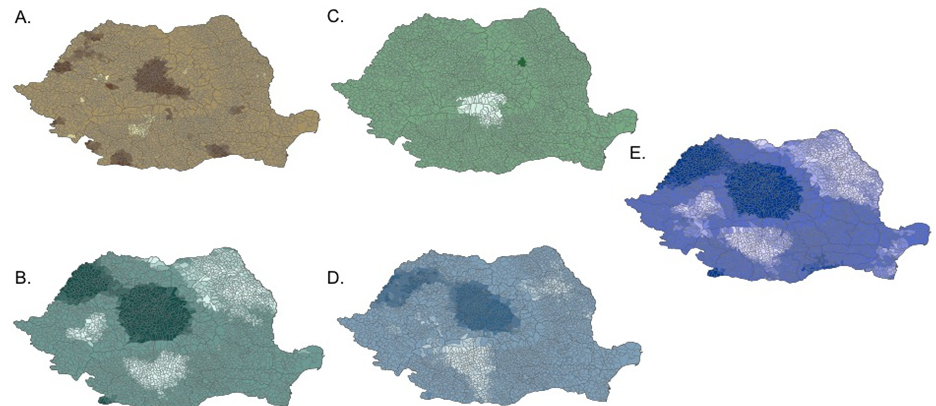
Figure 4. Hot spot analysis for quality of life parameters. A ) Lack of Electricity, B ) Insecure Housing, C ) Lack of ‘improved water source’, D ) High incidence of diarrheal disease, and E ) Lack of education beyond 8th grade. Using spatial autocorrelation (Global Moran’s I), each variable was analyzed to determine whether the pattern expressed in the population was random. Significant autocorrelation (non-random pattern or clustering) was determined by z-score and accompanying p-value (p=0.05). Significance or lack thereof suggests whether